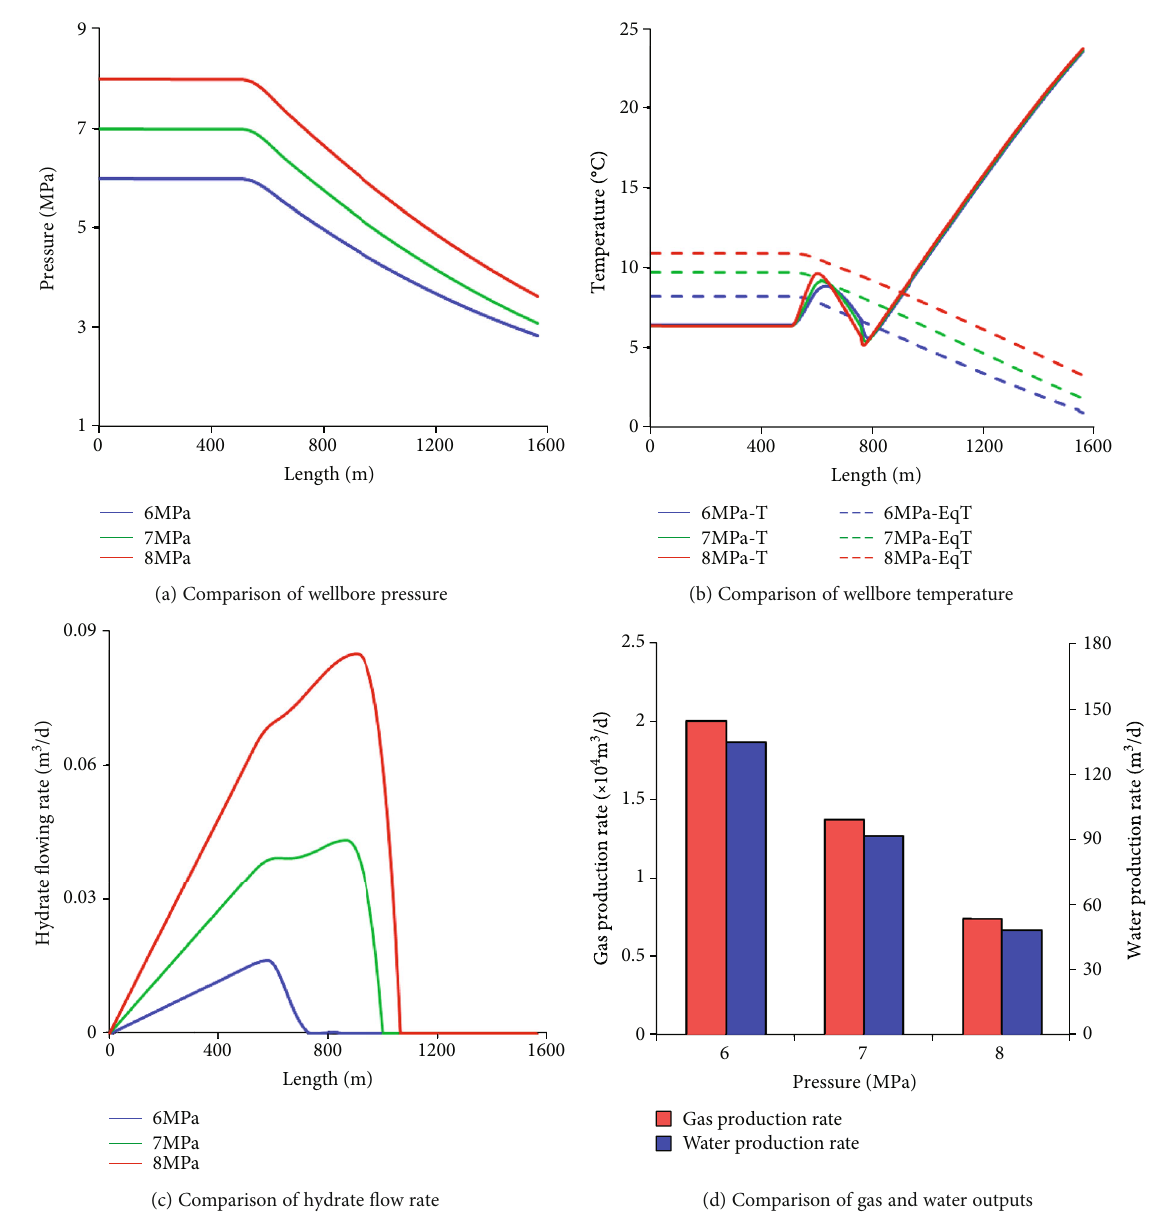
Figure 8: Comparison of each wellbore parameter under di ff erent toe-end